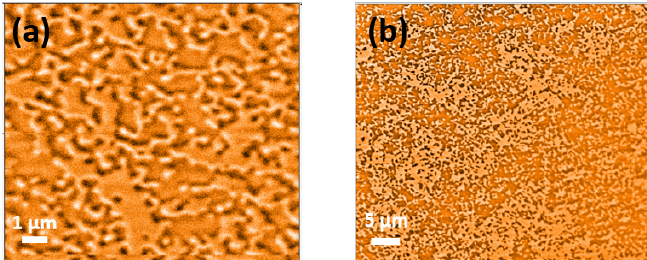
Figure 4. ( a , b ) MFM images of the magnetic domain structures of a 40 nm thick Tb 15 Co 85 template grown without an external field. The magnetization points in or out of the sample plane in the dark and light areas,